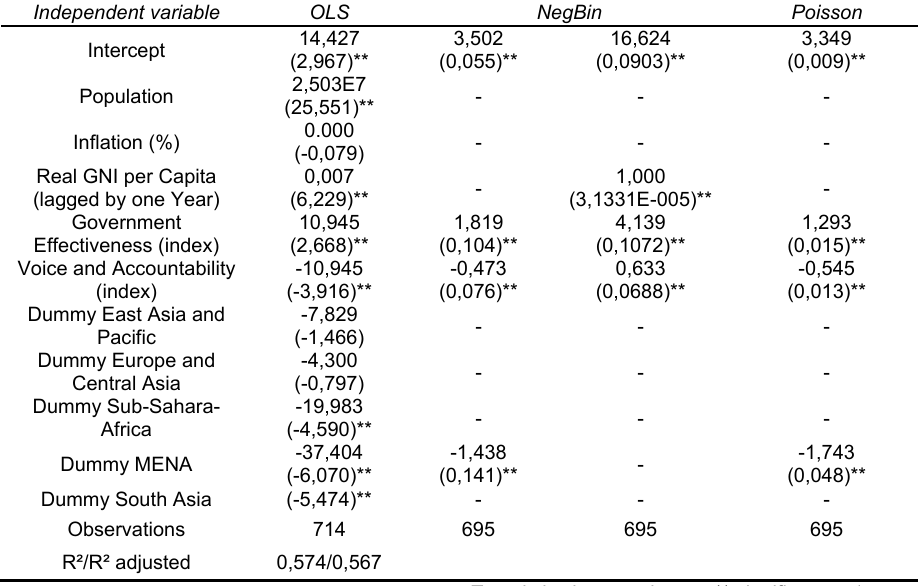
Table 2: Results of the regression